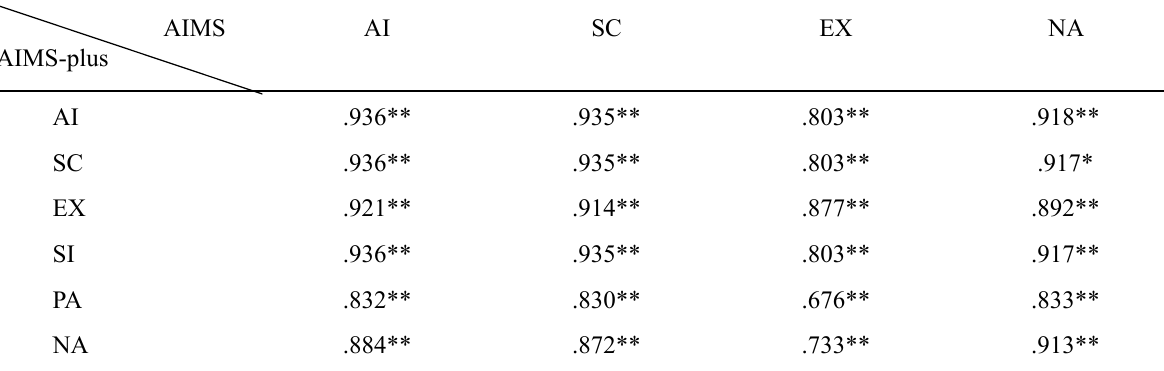
Correlations between AIMS-plus and AIMS for Global AI and Scales (n=650)